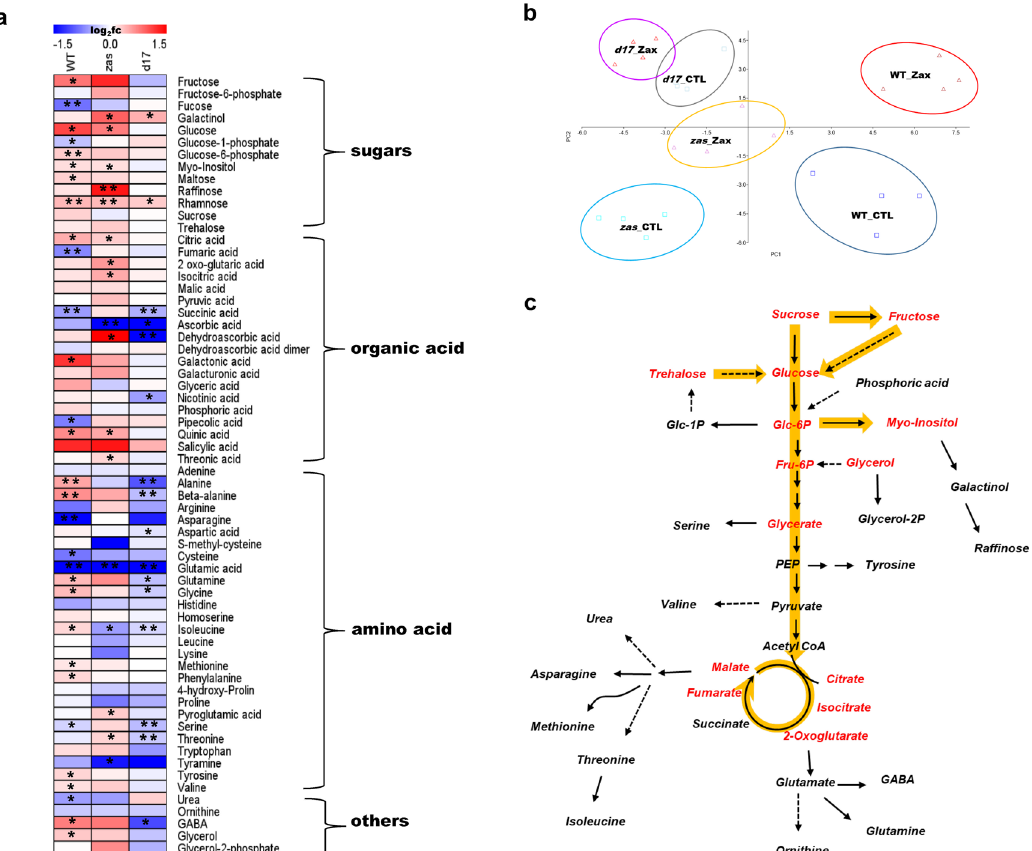
Fig. 3 The pro fi le of primary metabolites in roots of WT, zas , and d17 mutant. Primary metabolites extracted from roots for GC-MS, which were annotated and listed in Supplementary Data 7. n = 4 biological replicates. a Heatmap of root tissue showing relative accumulation of each metabolite as compared to those in control plants. For each metabolite, the value of the corresponding control was set to 1. Asterisks indicate statistically signi fi cant differences as compared to control by t -test (* p < 0.05, ** p < 0.01). b Principal component analysis (PCA) of root metabolites was performed using Past3 software. c The scheme of major metabolic changes in central metabolism after zaxinone treatment, which adapted from a. Orange arrows indicate sugar-related metabolites that mainly accumulated upon zaxinone treatment in WT and/or the zas mutant, but not in d17 . CTL control, Zax